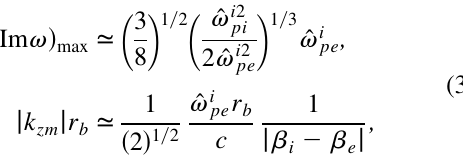
and (b) (cid:1) Re ! (cid:2) = ^ ! i pe r =c (cid:7) 3 in the absence of plasma outside the beam-plasma channel. b pe